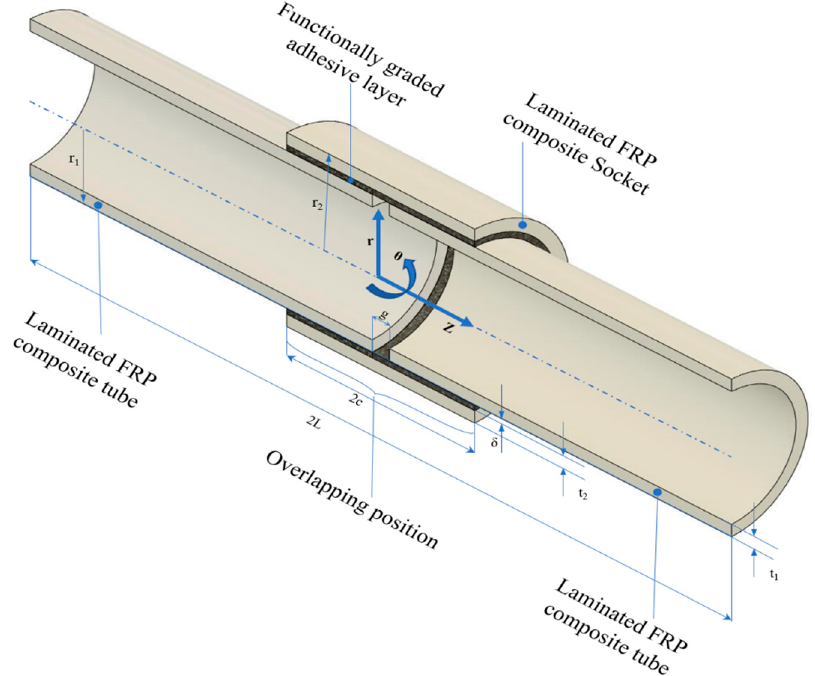
Figure 2. Geometrical design of FGA socket joint.